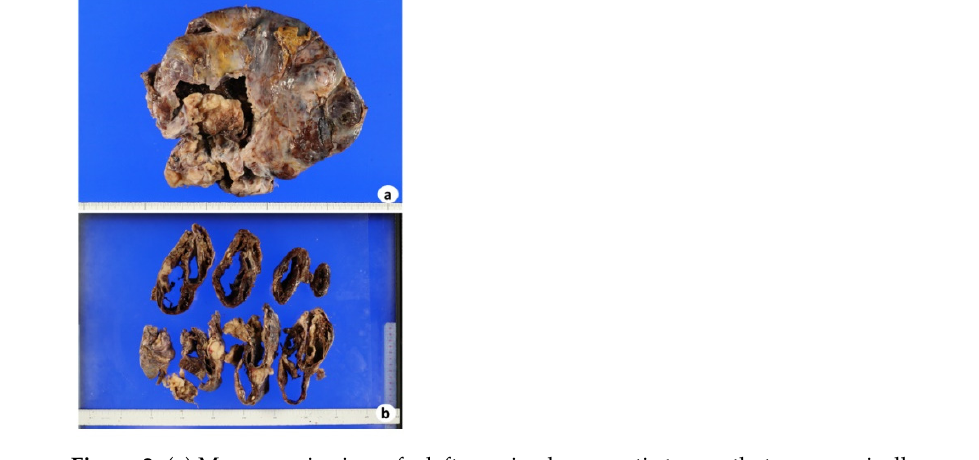
Figure 2. ( a ) Macroscopic view of a left-ovarian large cystic tumor that was surgically removed. ( b ) The cut surface of the tumor is multilocular with hemorrhage and necrosis.